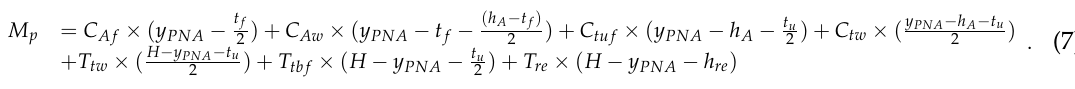
Table 6. Internal force components in case the plastic neutral axis exists at the web of the